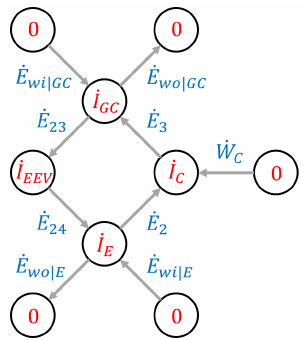
Figure 8. Heat pump graph representation with assigned attribute